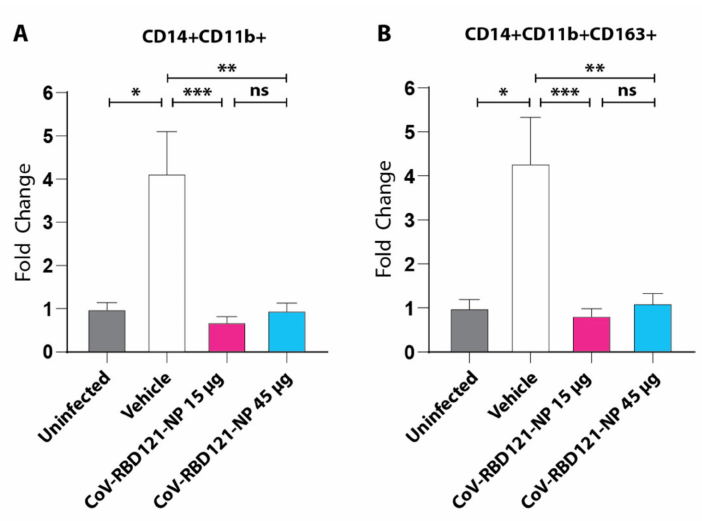
Figure 6. Effect of vaccination on monocytes and macrophages infiltration into lung tissue following challenge with SARS-CoV-2. ( A , B ) Lung tissues were stained with antibodies to identify monocytes (CD14+CD11b+) cells ( A ) or macrophages (CD14+CD11b+CD163+). Data from quantification of 14–35 images per group are plotted relative to those in tissue from uninfected mice with significance determined by one-way ANOVA with Tukey’s post hoc test, * p < 0.05, ** p < 0.01, *** p < 0.001, ns = not